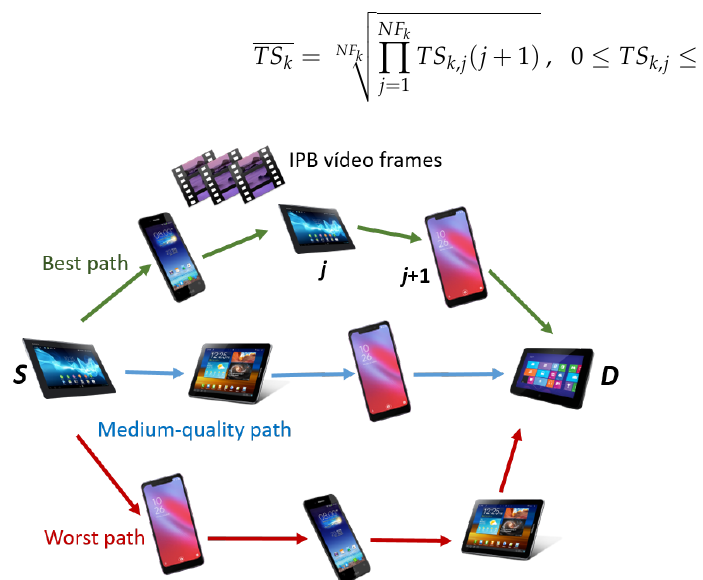
Figure 3. General mobile ad hoc network (MANET) scheme to transmit video frames from a source S to its destination D . Paths are arranged according to a combined QoS and social multimetric score, see Equation